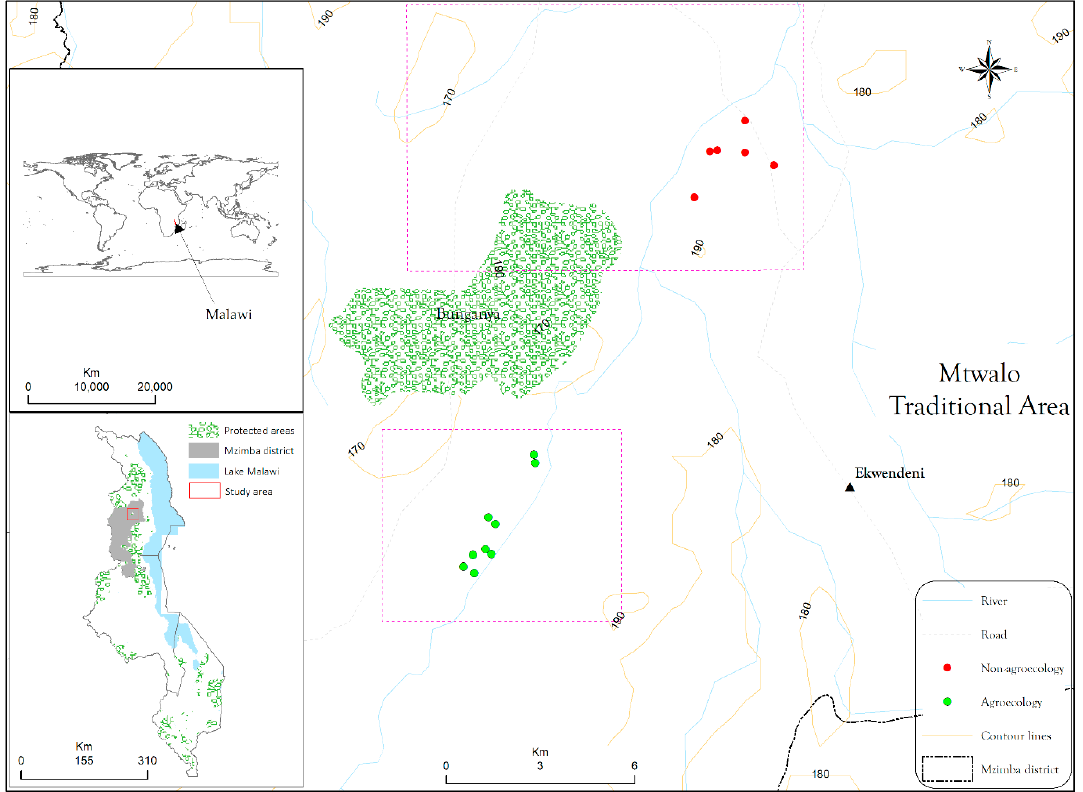
Figure 1. Location of study areas. Dotted pink rectangles represent areas demarcated by participants for ecosystem service use mapping.